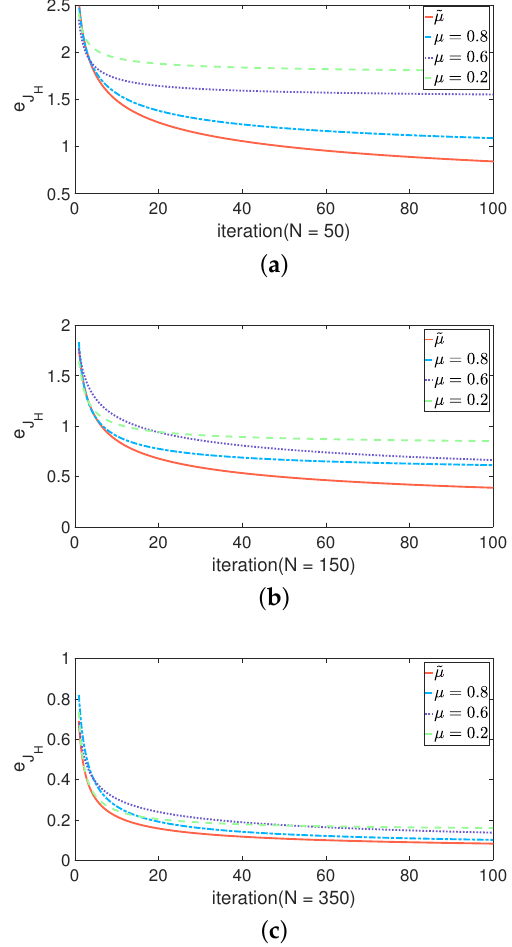
Figure 3. Convergence curves of dynamic weight and fixed weight with different numbers of particles. ( a ) N = 50; ( b ) N = 150; ( c ) N =